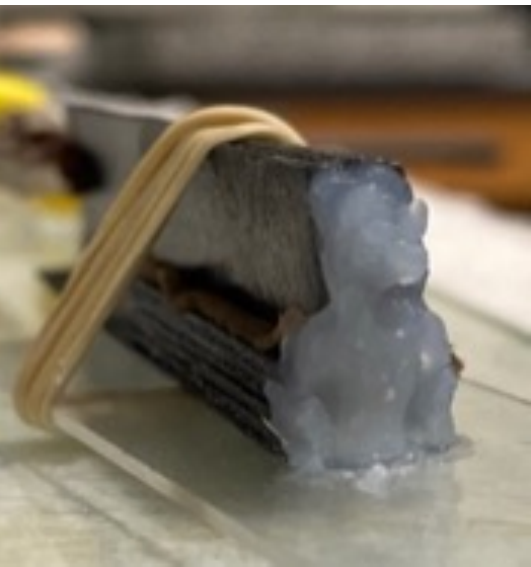
Figure 4. Salt Bridge . Capacitor in offset configuration with molded ‘salt bridge’ at one end.